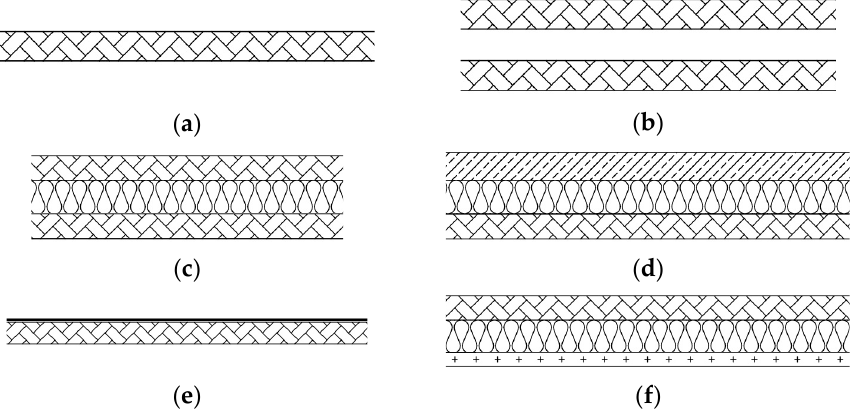
Figure 2. Schemes of tested arrangements ( a ) single panel; ( b ) double set-up with empty cavity; ( c ) double set-up with mineral wool; ( d ) panel with a floating floor; ( e ) panel with a lightweight floor covering; ( f ) panel with a suspended ceiling.